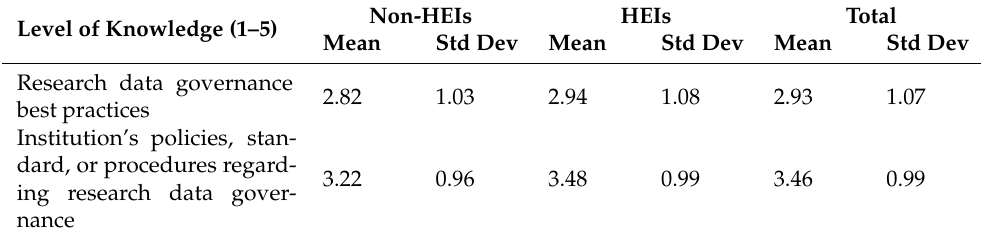
Table 5. Indonesian scientists’ level of